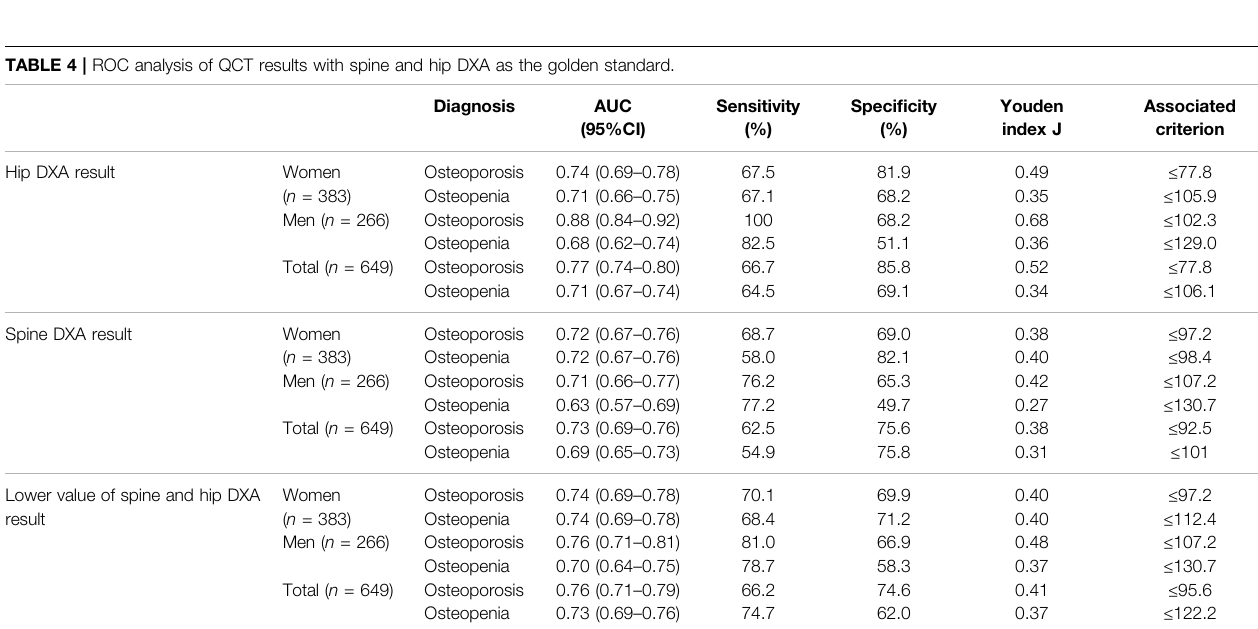
FIGURE 5 | Confusion matrix of QCT and spine DXA diagnosis result comparison.